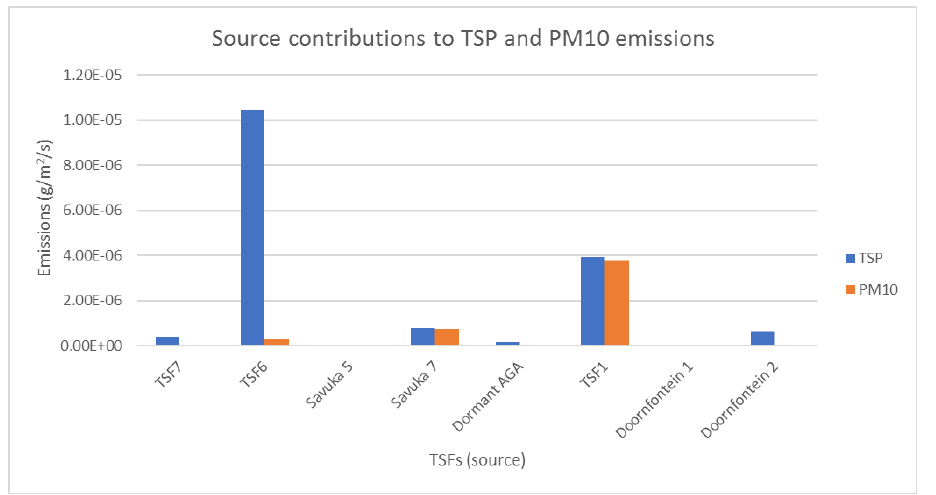
Figure 5. Source contribution to overall emission rates TSP and PM10.